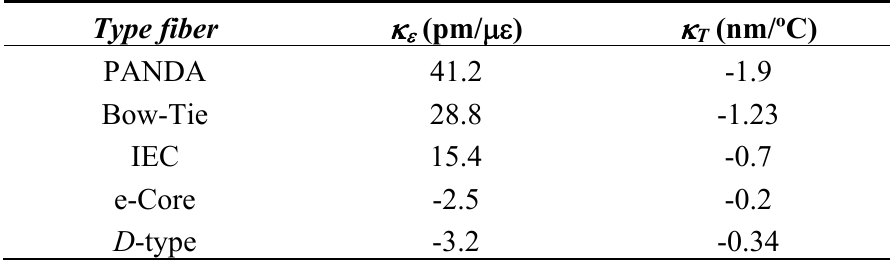
Table 2. Strain and temperature coefficients for all Hi-Bi fiber loop